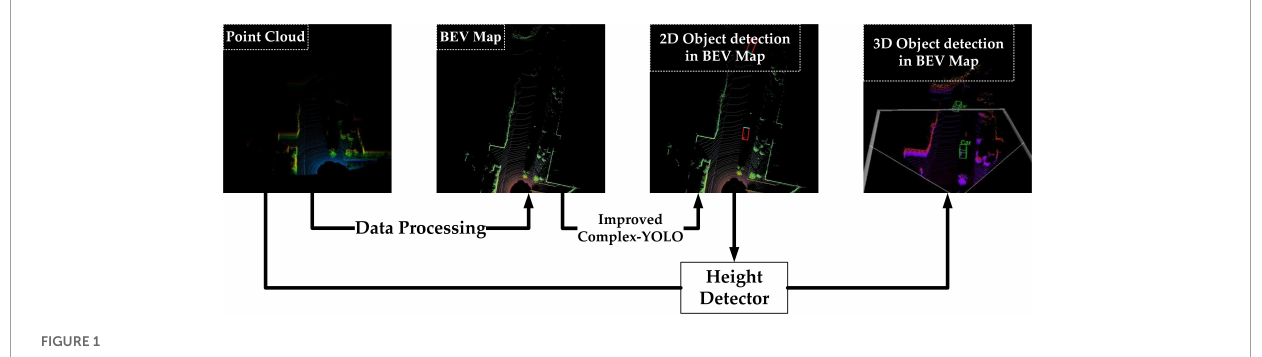
FIGURE1 3D object detection flow chart.